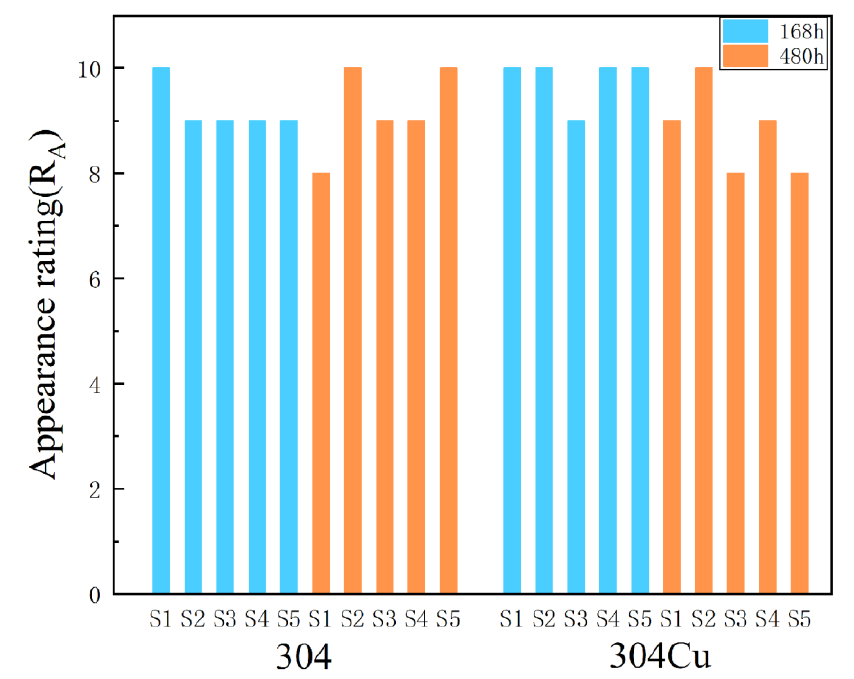
Figure 3. Appearance rating of stainless steel after salt spray test in 5 wt.% NaCl.